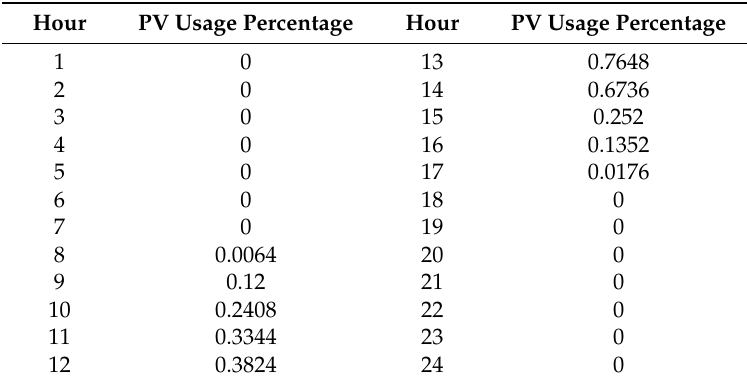
Table 1. Percentage values of PV arrays rated power used in the system.